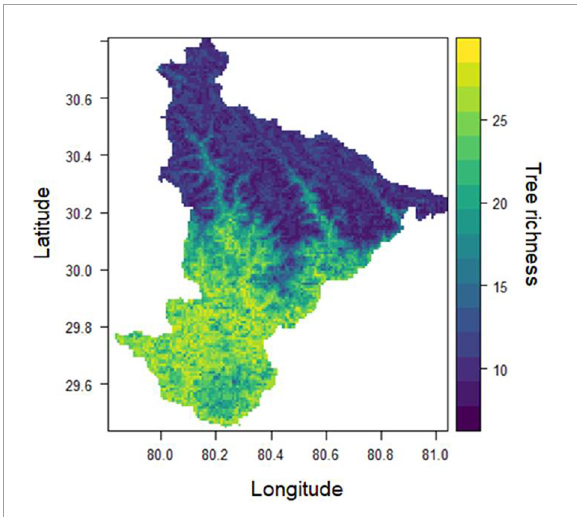
FIGURE3 Tree species richness map, derived from adding all individual species distribution maps. environmental variables with tree species richness. The beta coefficient, R 2 value, and root mean square error were used to assess the model’s performance.